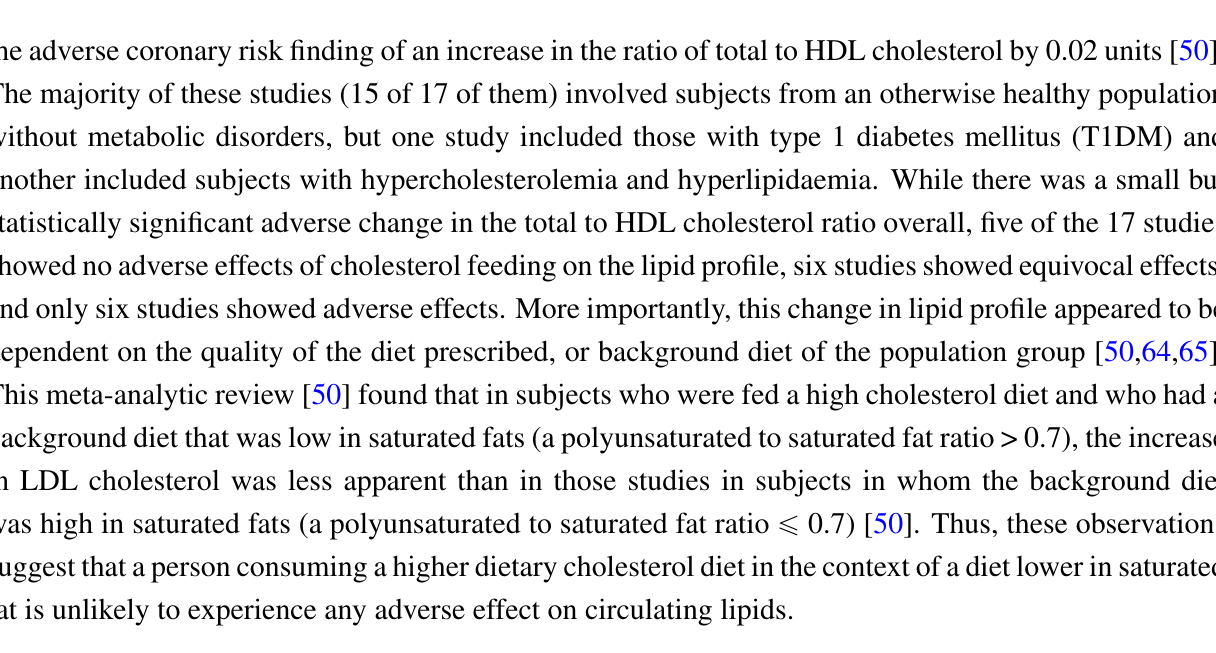
Table 2. Effect of egg consumption on cholesterol levels in the general